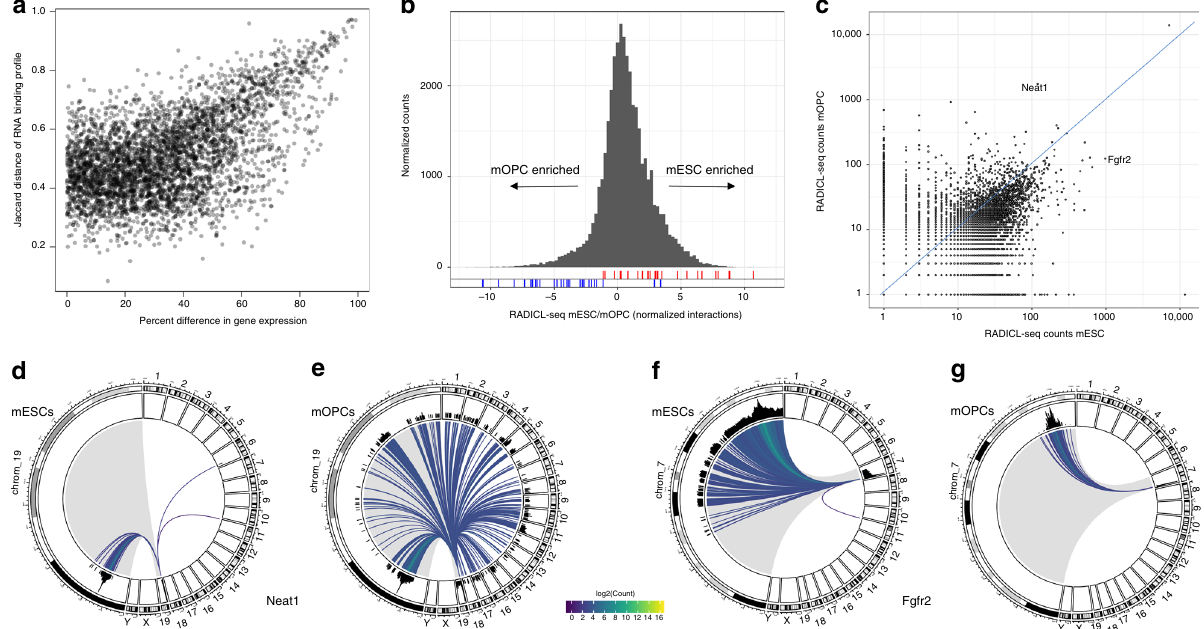
Fig. 5 Cell-type-speci fi c RNA – chromatin interaction patterns. a For each gene, the Jaccard distance between the genome-wide RNA – DNA binding pro fi les in mESCs and mOPCs is compared with the difference in capture rate (proxy for gene expression) between the two cell types. b Distribution of the log 2 ratios of RADICL-seq mESC to mOPC DNA normalized tag counts for targeted gene promoter regions, which are de fi ned as ±2 kb around the TSS. Cell-type-speci fi c marker gene positions are highlighted for both mESCs (red) and mOPCs (blue). Counts were normalized by library size. c RADICL-seq counts of unique genomic targets per interacting RNA in mESCs vs. mOPCs. d , e Circos plots depicting Neat1 genomic interactions in mESCs and mOPCs, respectively. f , g Circos plots depicting Fgfr2 genomic interactions in mESCs and mOPCs, respectively. Each line represents the interaction between the genic transcript and the contacted genomic bin, while its color indicates log 2 of the RADICL-seq count. The chromosome of origin of the RNA under investigation is shown enlarged (gray shading) on the left portion of each circos plot. All panels were generated using signi fi cant total